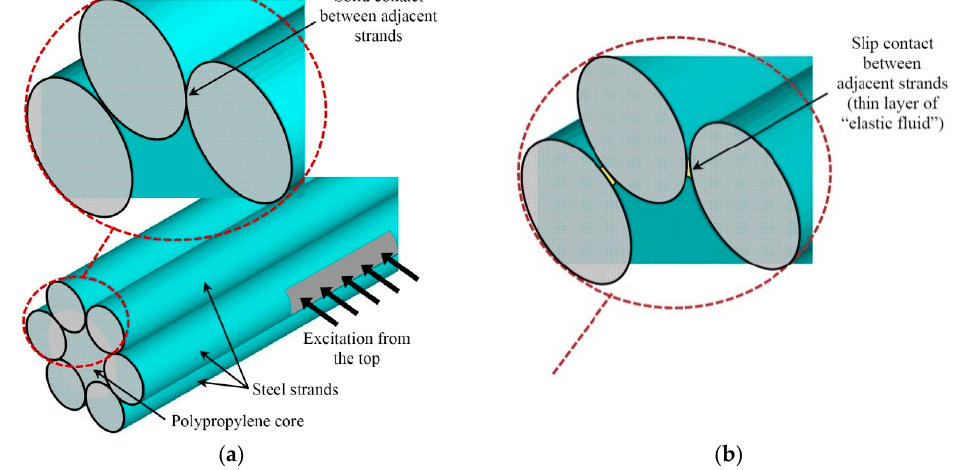
Figure 11. The 3D view of the multi-wire rope FE models in the case of a solid ( a ) and a slip ( b ) contact between neighboring strands.